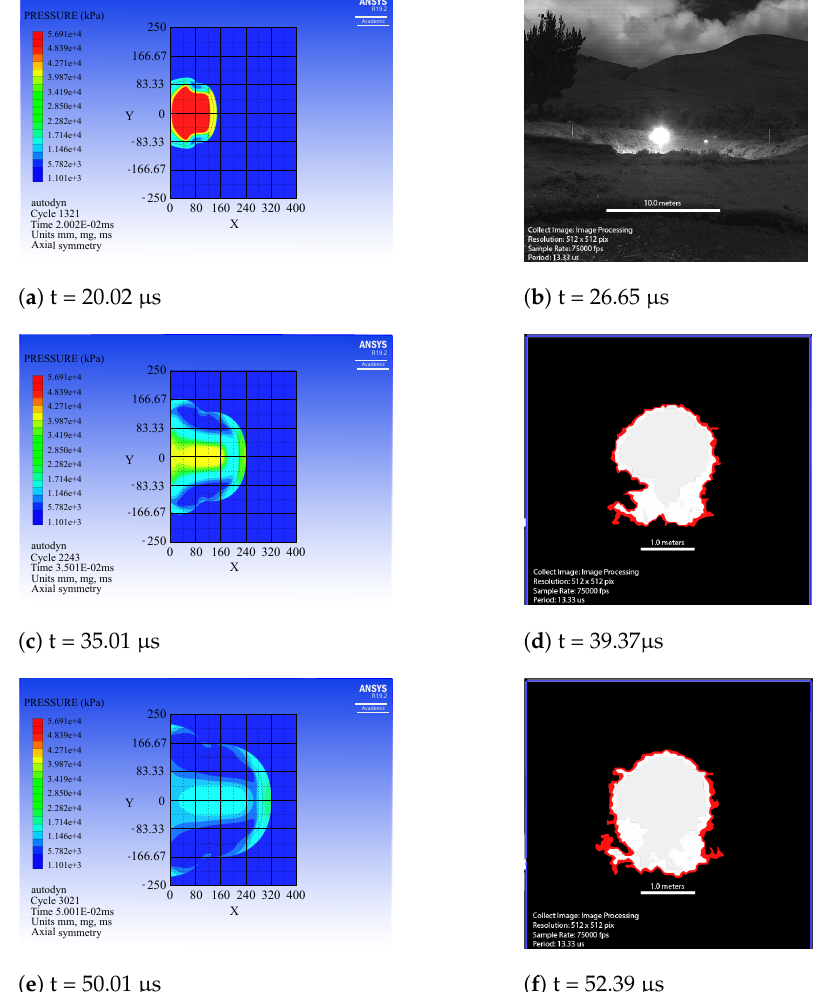
Figure 12. Numerical and experimental results for 3D cone charge of 150 g of pentolite